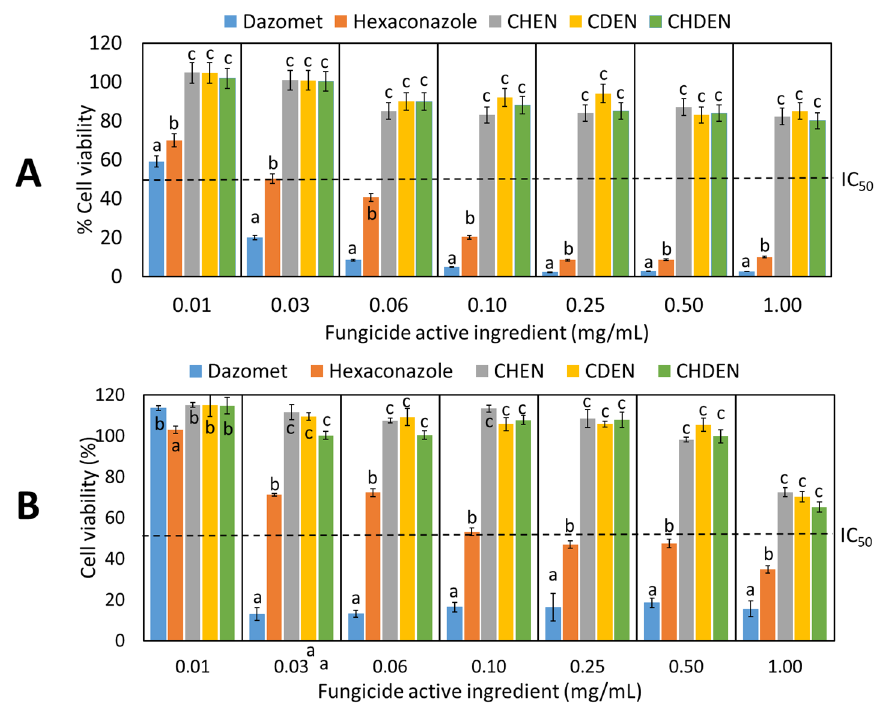
Figure 1. In vitro cell viability of ( A ) V79-4 hamster lung cells and ( B ) 3T3 mouse fibroblast cells treated with pure fungicide and chitosan-based agronanofungicides, where di ff erent letters (a, b, c) in the same concentrations indicate significant di ff erences between means ( p ≤ 0.05) according to Tukey’s test; the error bars represent the standard deviation of the